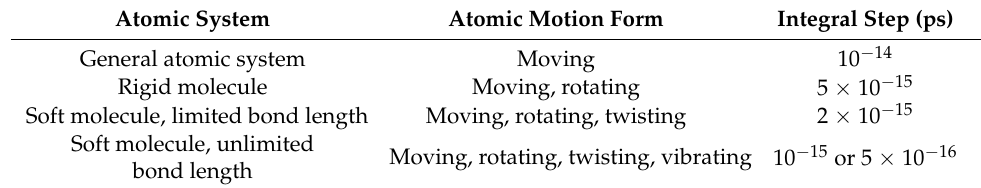
Table 1. Integration step for atomic